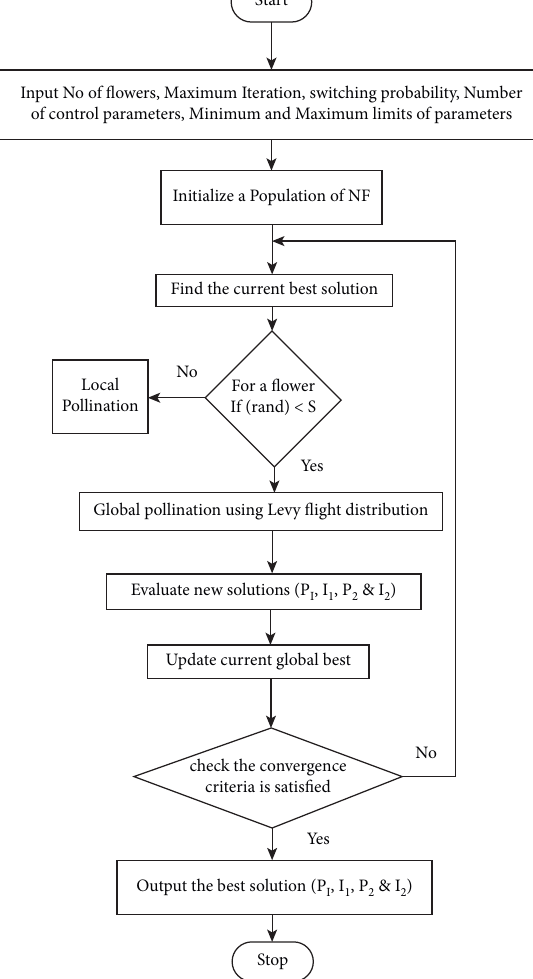
Figure 4: (a) Digression in the frequency of area-1 (Hz) vs time (s). (b) Digression in the frequency of area-2 (Hz) vs time (s). (c) Digression in tie-line power (p.u.MW) vs time (s). (d) Digression in control input (p.u.MW) in area-1vs time (s). (e) Digression in control input (p.u.MW) in area-2Vs time